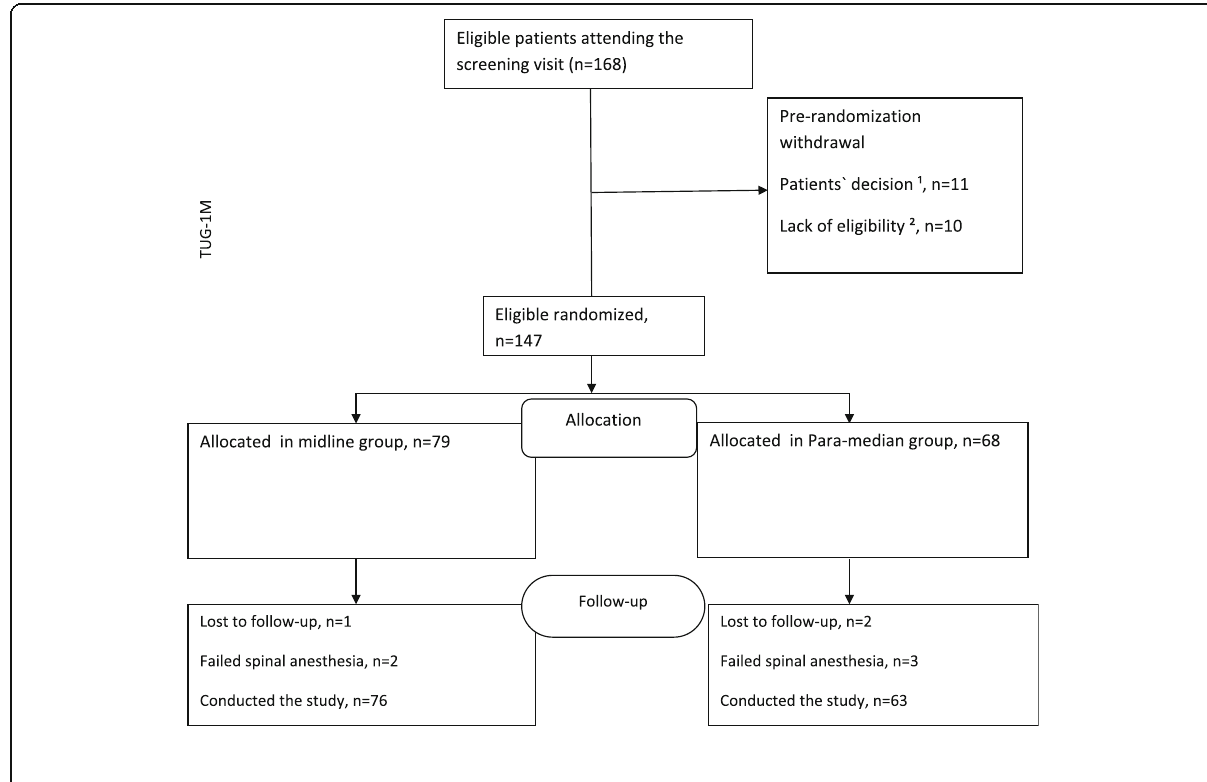
Fig. 1 Flow of participants through the